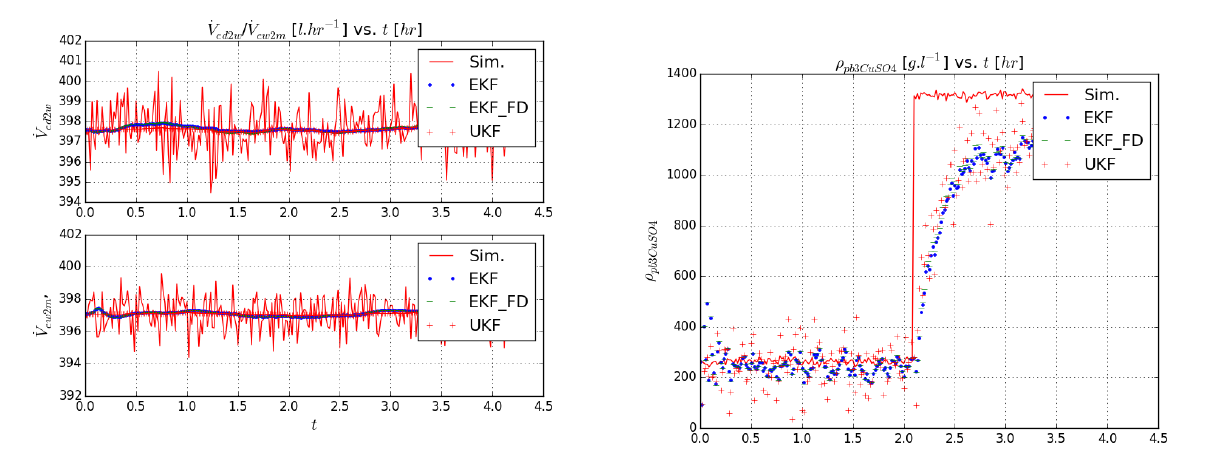
Figure 9: Estimation of ρ ew, H ρ em, H . 2 SO 4